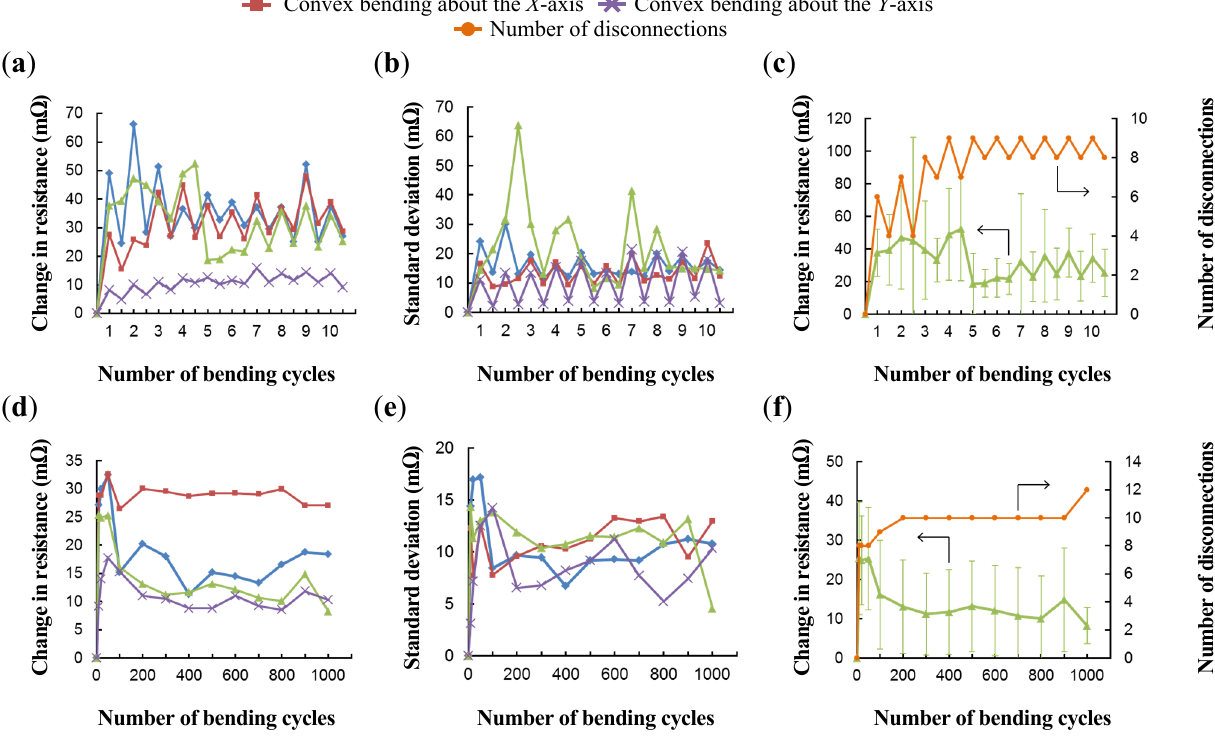
Figure 16. Change in resistance during the bending test for a curvature radius of 2.5 mm: ( a – c ) continuous measurements; ( d – f ) intermittent measurements; and ( c , f ) concave bending about the Y